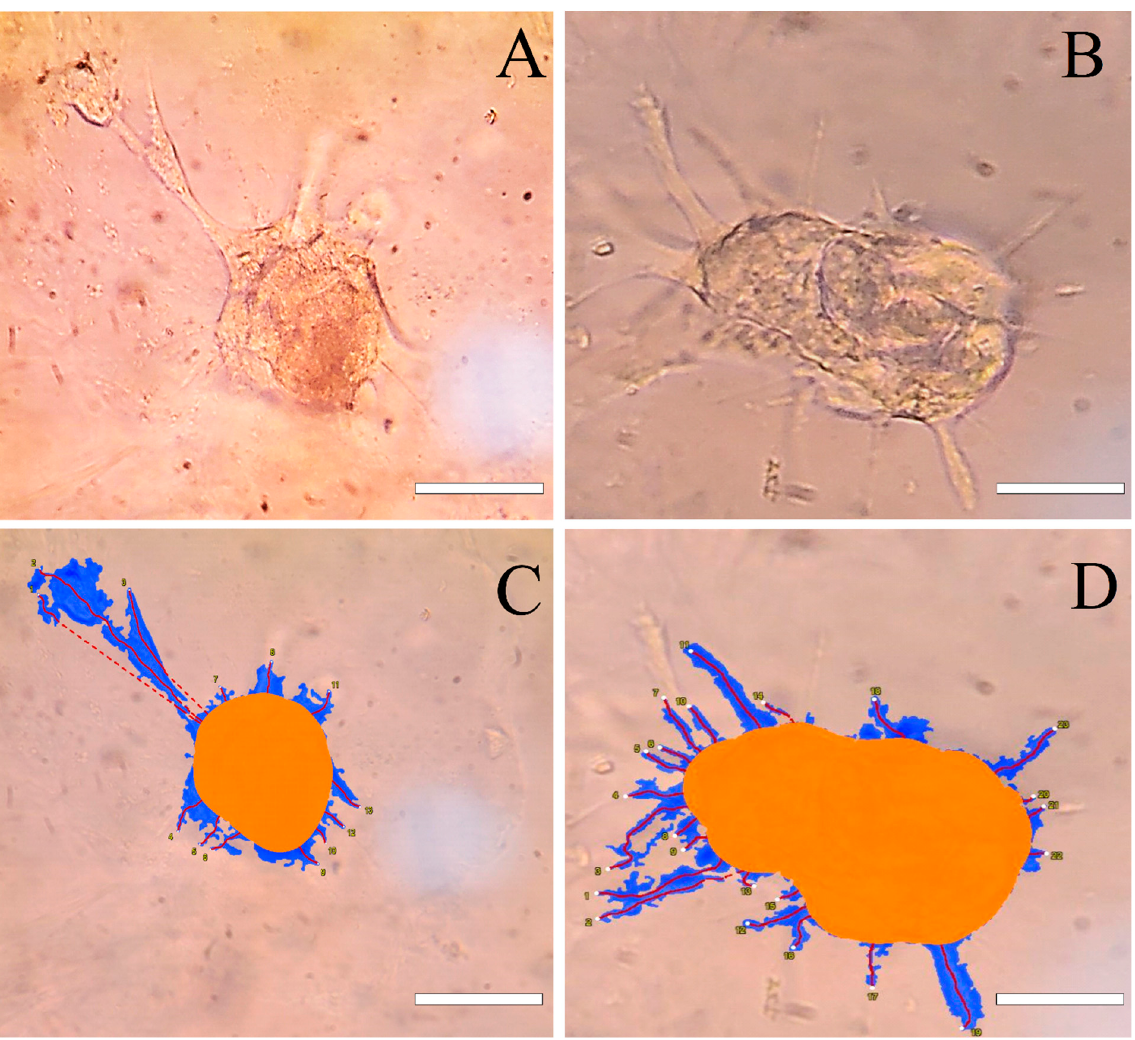
Figure 4. ( A – D ): Bright-field observation of the co-culture clusteroids sprouting after 7 days of culture with a cell ratio of 5:1 (Hep-G2:HUVEC) in 5 mg mL − 1 Matrigel. The corresponding Wimsprouts analysis of ( A,B ) is shown in ( C,D ). The bar is 50 μ m.